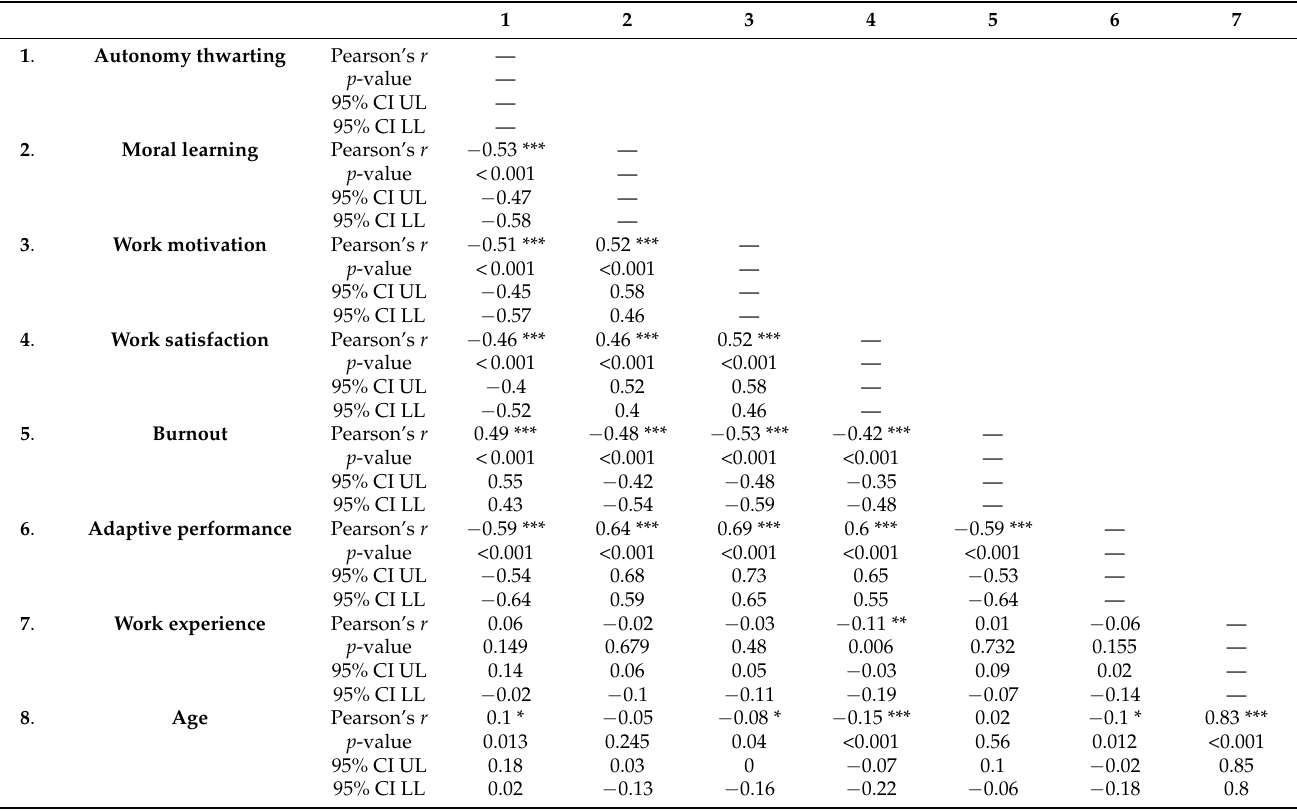
Table 1. Correlations between Age and Work Experience and variables of interest.